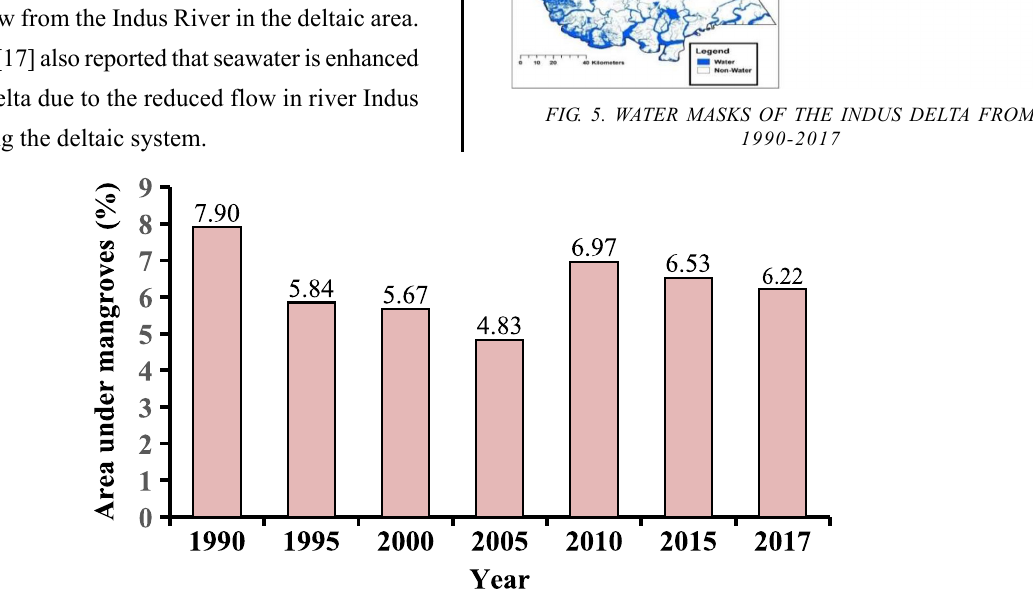
FIG. 4.GRAPHICAL REPRESENTATION OF TEMPORAL DYNAMICS OF MANGROVES IN THE INDUS DELTA